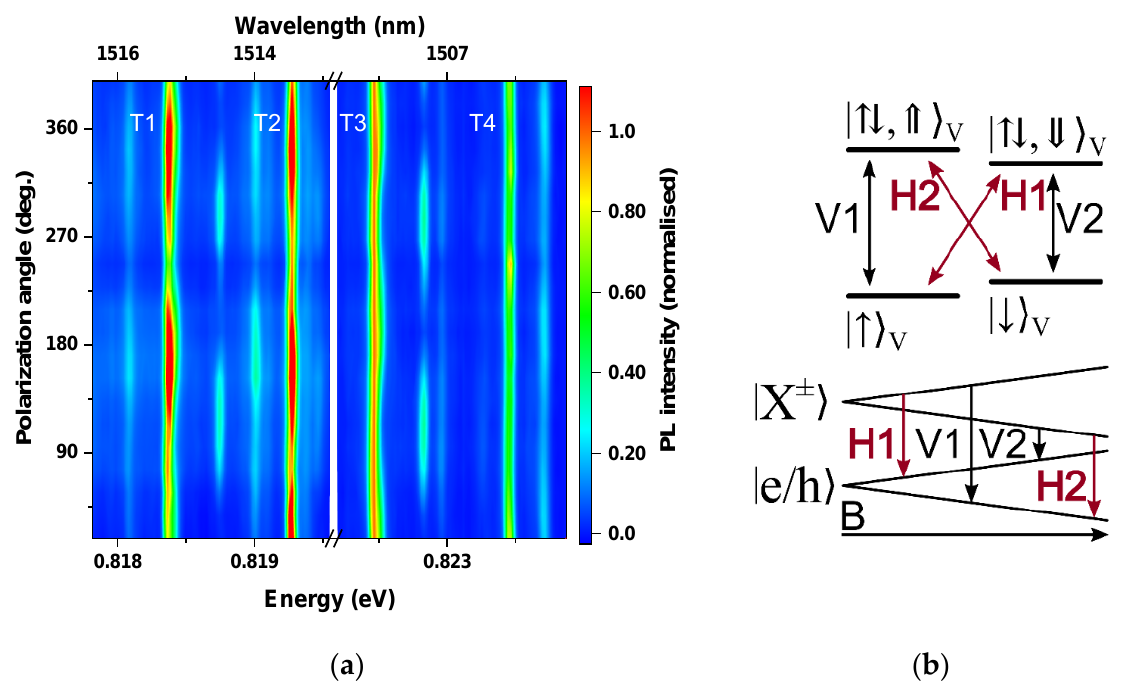
Figure 2. ( a ) Linear polarization-dependent photoluminescence (PL) spectra in zero magnetic field. ( b ) Energy level diagram of negative trion states in Voigt configuration. All four optical transitions are allowed, and polarization selection rules are indicated. The evolution of energy vs magnetic field for two groups of transitions with orthogonal linear polarizations (V1 and V2—“outer”; H1 and H2—“inner”) due to Zeeman splittings of initial (trion) and final (dot with single charge) states.